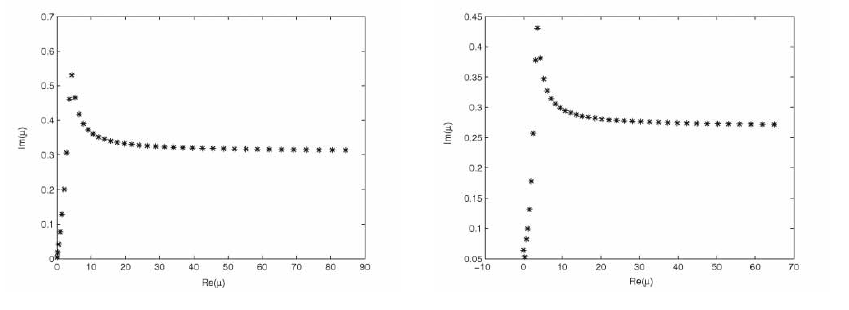
Figure 5. First 40 discrete (new) eigenvalues in the plane (Re μ, Im μ ), N = 300, L = 15, γ = 2, I =